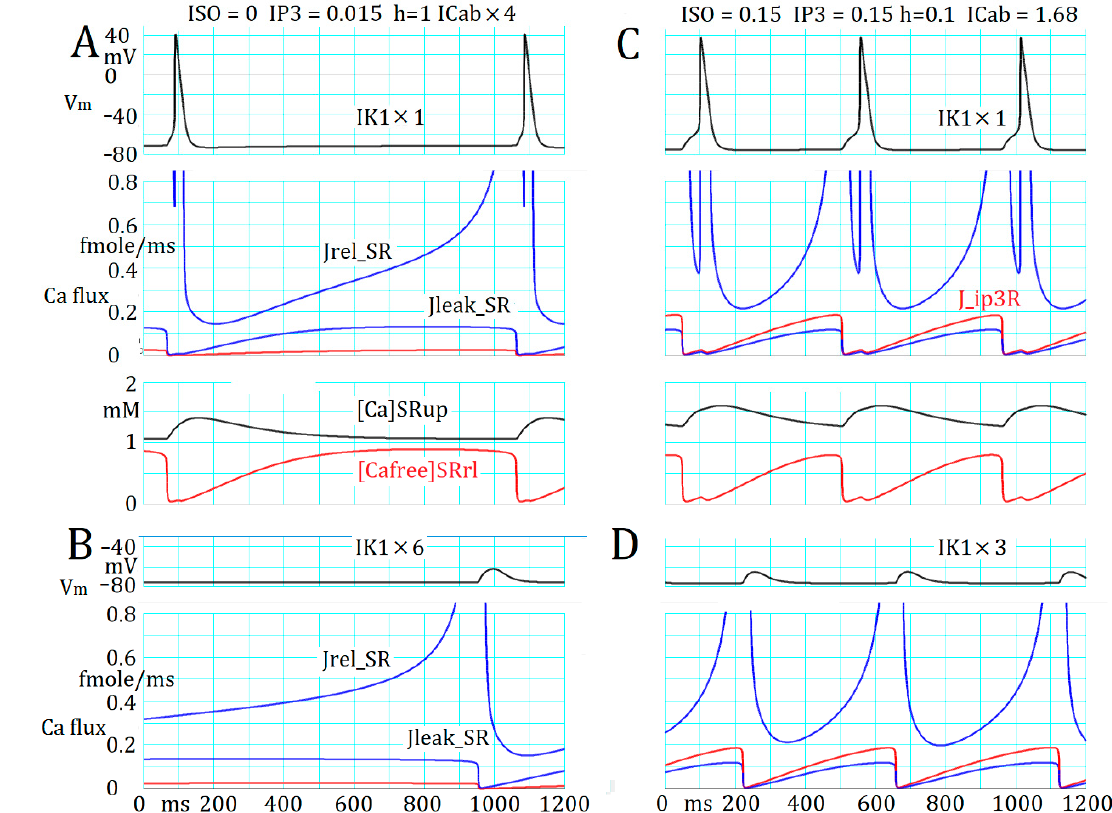
Figure 3 . ( A ) Time-dependent changes in J RyR , J IP3R (blue and red in the middle panel), [Ca 2+ ] SRup and [Ca 2+ ] SRrl (black and red in the bottom panel), when the repetitive action potential (AP; top panel) was evoked. ( B ) The transient depolarization (TD) when triggering APs was interfered with by increasing the inward rectifier potassium current ( I K1 ) conductance six-fold. Almost the same time course of J RyR , [Ca 2+ ] SRup , and [Ca 2+ ] SRrl were observed but are not demonstrated. ( C , D ) Records were obtained as in A and B in the presence of noradrenaline (NA) stimulation. The triggering AP by the preceding TD in ( C ) was much delayed if compared with records in ( A ). This is because the amplitude of TD was partially depressed through the enlargement of I NaK through an accumulation of [Na + ] i during the repetitive AP TD s. Alternatively, the AP TD s could be evoked by applying NA at 0.15 μ M at the control sfI Cabg = 1.68.